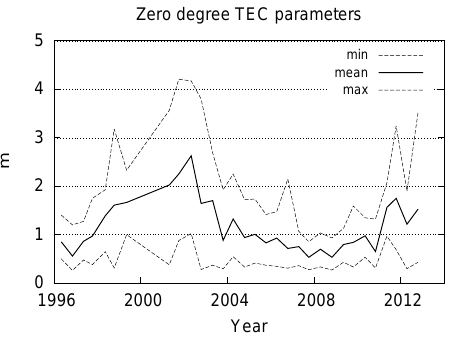
Figure 3. Zero degree TEC parameters of local ionosphere models.